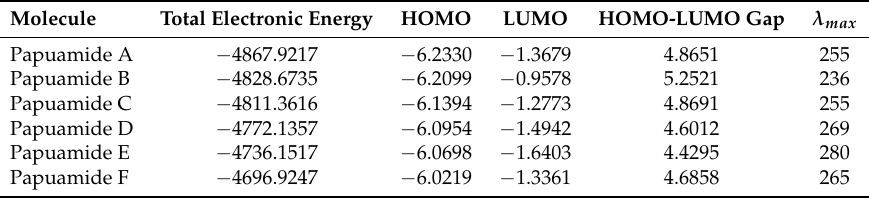
Table 1. Electronic energies of the neutral molecular systems (in au) of Papuamides A–F, the HOMO and LUMO orbital energies as well as the HOMO–LUMO gap (in eV), and the maximum absorption wavelengths λ max (in nm) calculated with the MN12SX density functional and the Def2TZVP basis set using water as solvent simulated with the SMD parametrization of the IEF-PCM